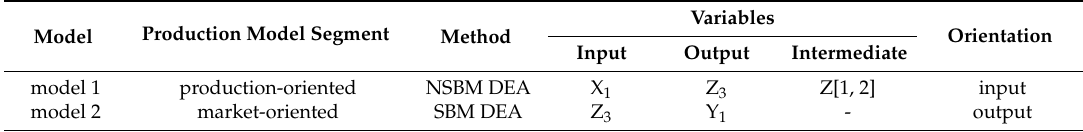
Table 2. DEA model